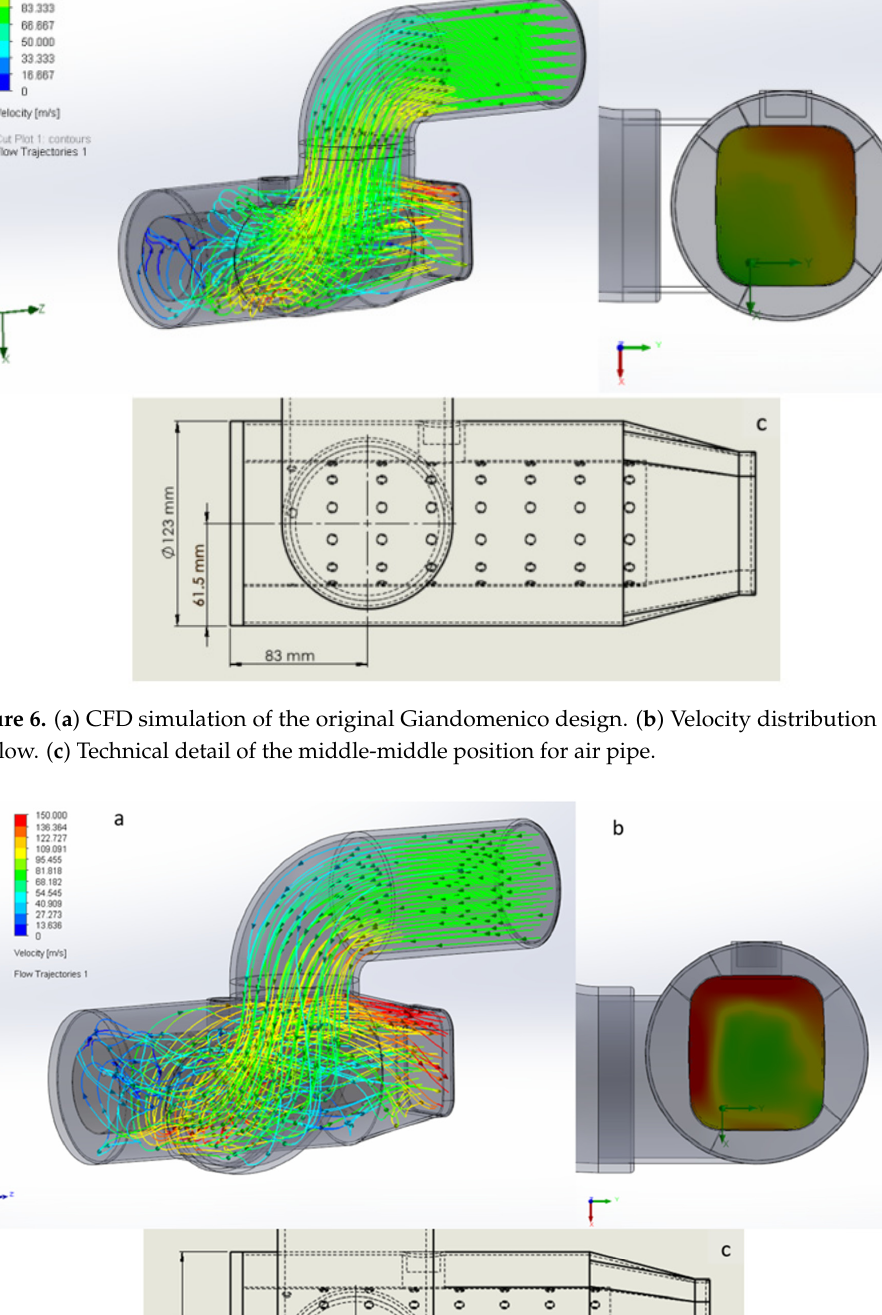
bution of the airflow was less homogeneous (Figure 7b) than the results of the previous design. This simulation was not satisfactory, with a significant deterioration of the veloc- ity pattern at the output of the combustor.